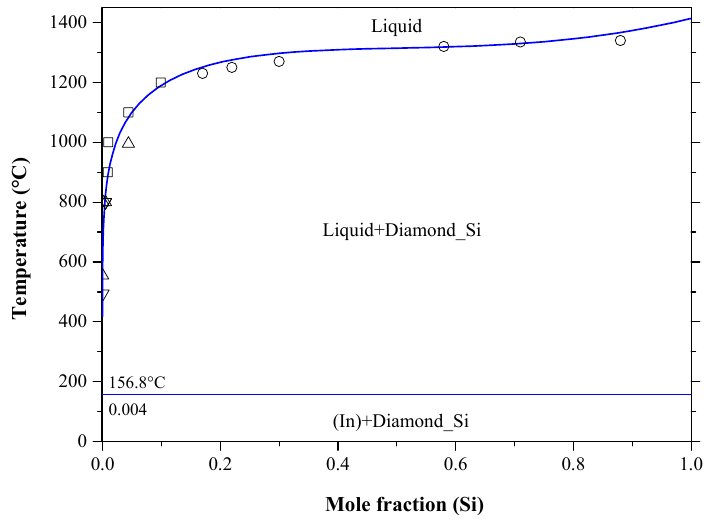
Figure 21. The calculated In-Si phase diagram ― : [124] based on the assessment of [52]; ○ : [186]; □ : [120]; Δ : [188]; : [178].